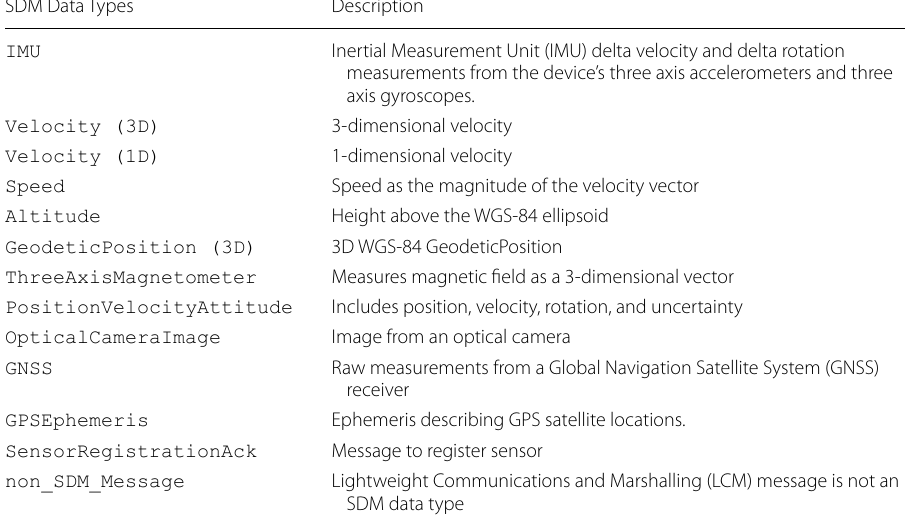
A new table is created for each data type and for each data log. The IMU table, for instance, would have 430 Million rows for the 1000 mission database if they were not split between